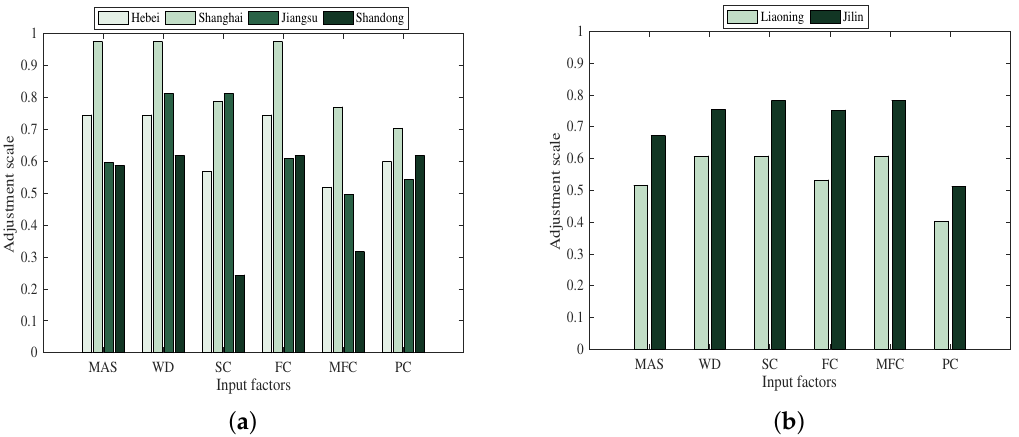
Figure 4. Analysis results: ( a ) the proportion of efficiency input adjustment in eastern China; ( b ) the proportion of efficiency input adjustment in north-east